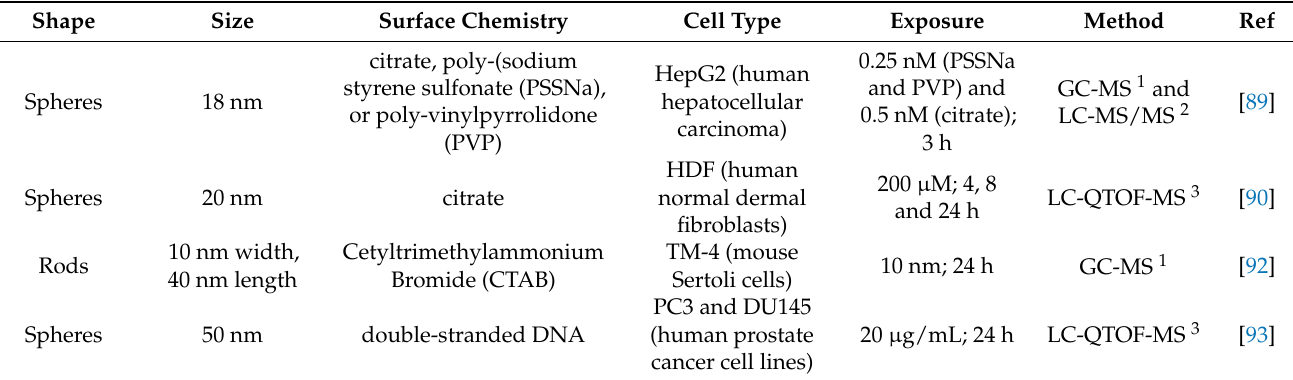
Table 4. Examples of metabolomic changes induced by AuNPs in